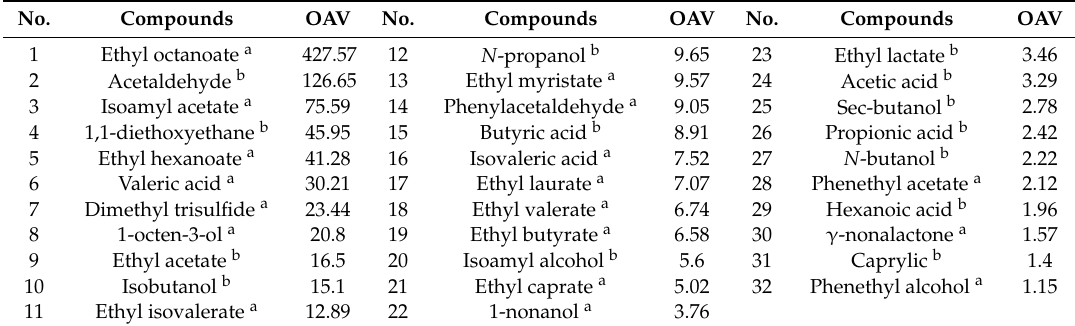
Table 4. Odor activity values (OAVs) of the key flavor compounds in